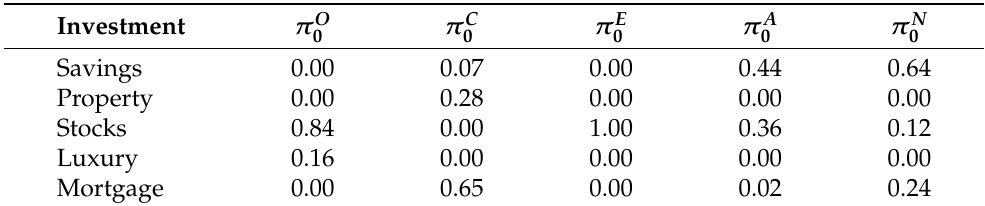
Table 4. Regularisation priors π a for each agent a ∈ {openness ( O ), conscientiousness ( C ), extraversion 0 ( E ), agreeableness ( A ), and neuroticism ( N